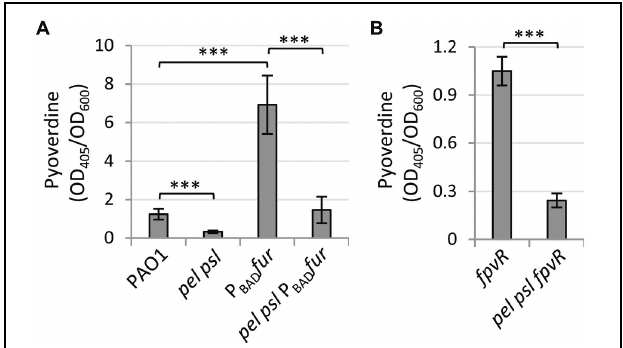
FIGURE 2 | Fur and pyoverdine signaling are not involved in exopolysaccharide-mediated pyoverdine regulation. Pyoverdine production in (A) P. aeruginosa PAO1, the pel psl mutant, and their derivatives in which the native fur gene was replaced by an arabinose-inducible allele (P BAD fur ), and (B) P. aeruginosa PAO1 fpvR and pel psl fpvR mutants. Bacteria were cultured in TSBD without arabinose at 37 ◦ C under static conditions for 14 h, and values are the mean ( ± SD) of at least three independent assays. Asterisks indicate statistically significant differences with respect to the corresponding parental strain ( ∗∗∗ p <